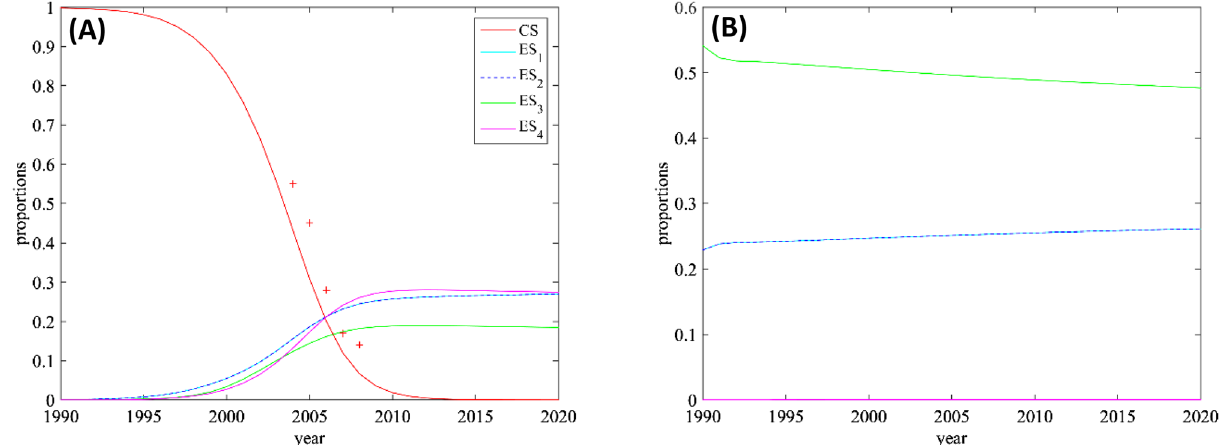
Figure 4. Estimated average proportions of the classical and emerging strains in the study area. ( A ) The plain lines correspond to the simulated proportions and the red crosses correspond to the proportions of CS in the data. ( B ) Simulated proportions of the ESs obtained by assuming that the CS is absent. In both cases, the parameter values correspond to the MLE (cid:31) ∗ . Note that the curves corresponding to the ESs 1 and 2 are